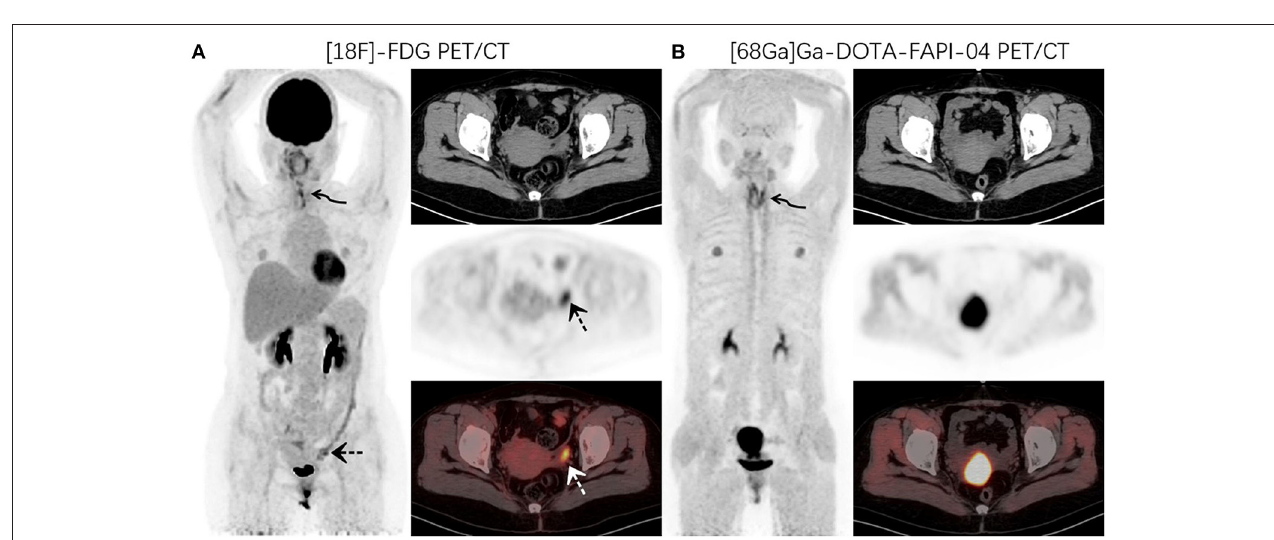
Frontiers in Medicine |